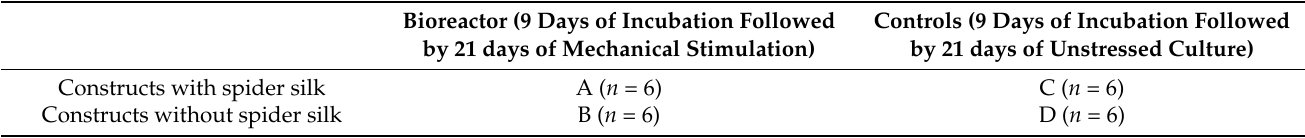
Table 1. Overview of experimental groups for mechanical stimulation using the bioreactor and corresponding controls. Bioreactor (9 Days of Incubation Followed Controls (9 Days of Incubation Followed by 21 days of Mechanical Stimulation) by 21 days of Unstressed Culture)